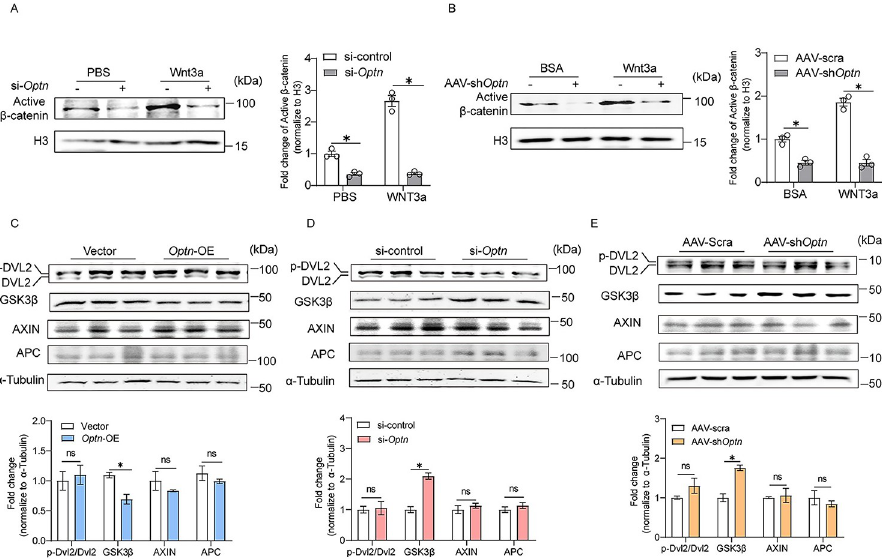
Fig 4. GSK3 β is negatively regulated by OPTN during myogenesis. (A, B) Representative immunoblotting analysis and quantification of active β -catenin protein levels in nuclear lysates extracted from si-control or si- Optn C2C12 cells incubated with Wnt3a or PBS for 24 hours at 4 days postdifferentiation (A) ( n = 3 independent experiment) and scramble shRNA or sh Optn TA muscle (intramuscular injection of Wnt3a at 1.5 days postinjury) at 5 days postinjury (B) ( n = 3 mice in each group). (C–E) Representative immunoblotting analysis (upper panel) and quantification (lower panel) of DVL2 phosphorylation, GSK3 β , AXIN, and APC protein levels in Optn -OE (C) and Optn KD (D) C2C12 cells at 4 days postdifferentiation ( n = 3 in each group), as well as in scramble shRNA or sh Optn muscle TA muscle at 5 days postinjury (E) ( n = 3 mice in each group). Data are presented as mean ± SEM. � P < 0.05 versus control. The underlying data for this figure can be found in S1 Data . The original blot for this figure can be found in S1 Raw Image . A AU : TheabbreviationlistofFig 4 hasbeenupdated : Pleaseverifythatallentriesarecorrect : AV, adeno-associated viral vector; APC, adenomatous polyposis coli protein; AXIN, axis inhibition protein; BSA, bovine serum albumin; DVL2, disheveled-2; GSK3 β , glycogen synthase kinase 3 β ; H3, histone H3, KD, knockdown; OE, overexpressing; Optn, optineurin; SEM, standard error of the mean; shRNA, short hairpin RNA; TA, tibialis